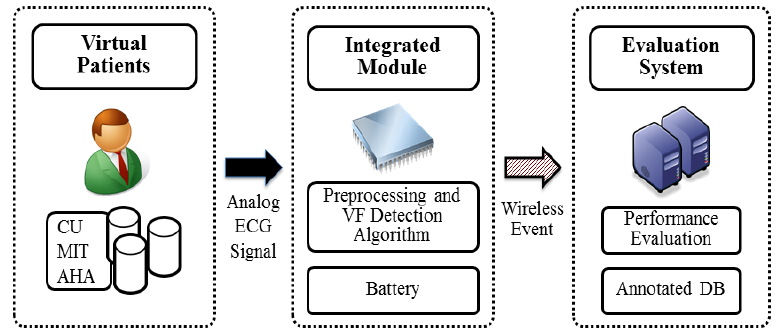
Figure 6. Different types of sinuous rhythms from CU database (62.5 Hz).